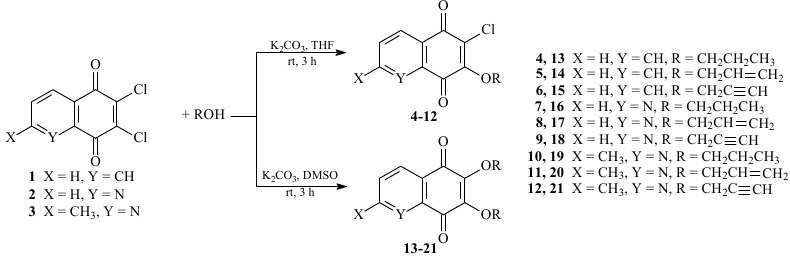
Scheme 1. The synthesis of 7-mono and 6,7-disubstituted derivatives ( 4 – 21 ) containing 1,4-